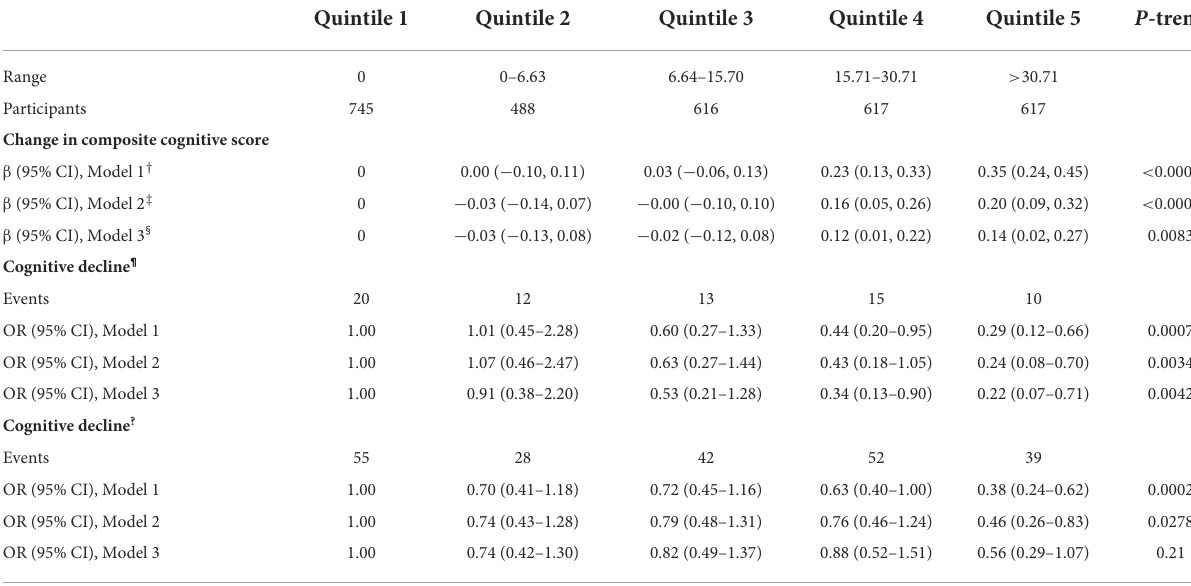
TABLE 5 Composition of animal and plant protein sources and cognitive decline *